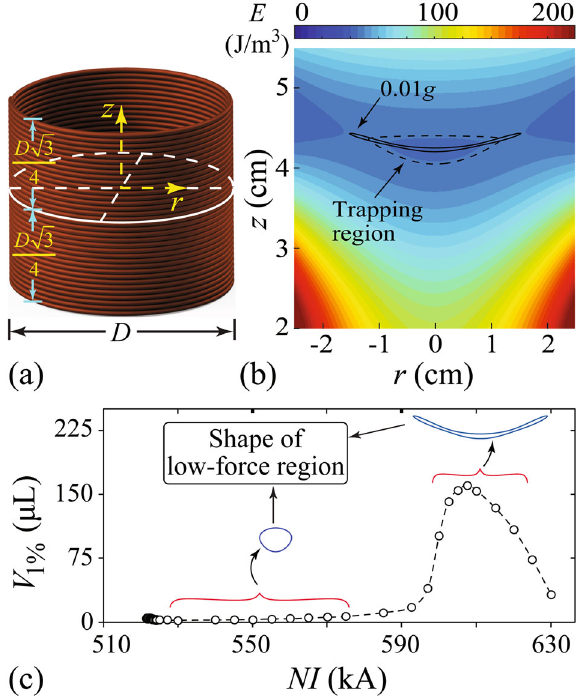
Fig. 1 Functional volume analysis for a conventional solenoid MLS. a Schematic of a solenoid with a diameter of D = 8 cm and a ffiffiffi p 3 D = 2 . b Calculated speci fi c potential energy E ( r ) of a height of small water sample placed in the magnetic fi eld. The turn-current NI of the solenoid is 607.5 kA. The origin of the coordinates is at the center of the solenoid. The dashed contour denotes the boundary of the trapping region, and the solid contour shows the low-force region (i.e., acceleration <0.01 g ). c The functional volume V 1% (i.e., the overlapping volume of the two contours) versus the turn-current NI . Representative shapes of the low-force region are